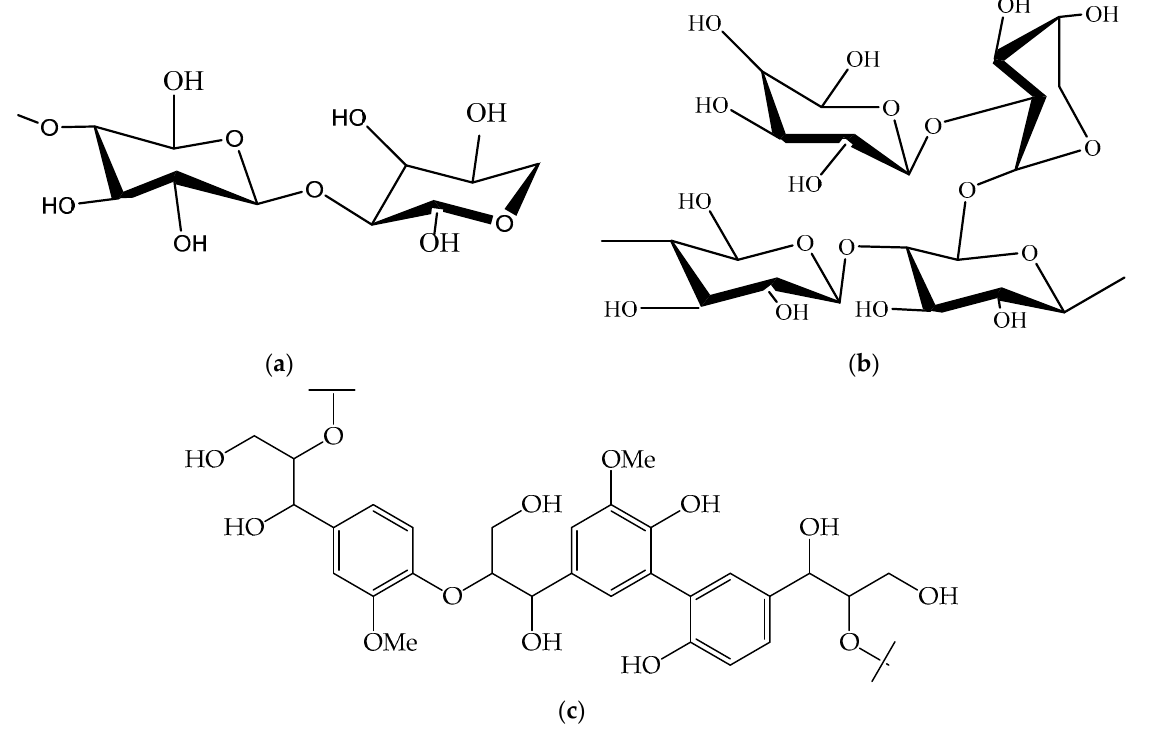
Figure 7. Structure of jute ( a ) cellulose, ( b ) hemicellulose, and ( c ) lignin.